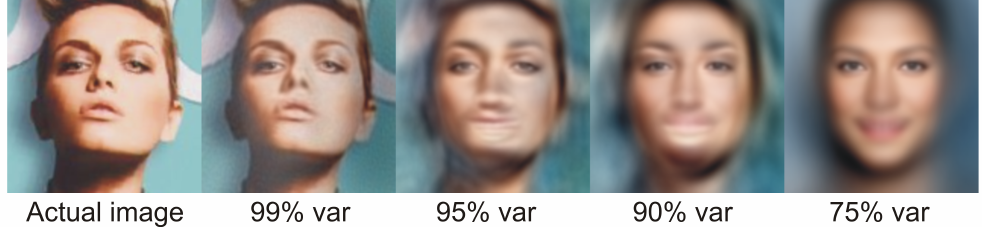
Figure 3. Actual (input) image and its reconstruction using various numbers of eigenfaces, which describe 99%, 95%, 90%, and 75% of variance,